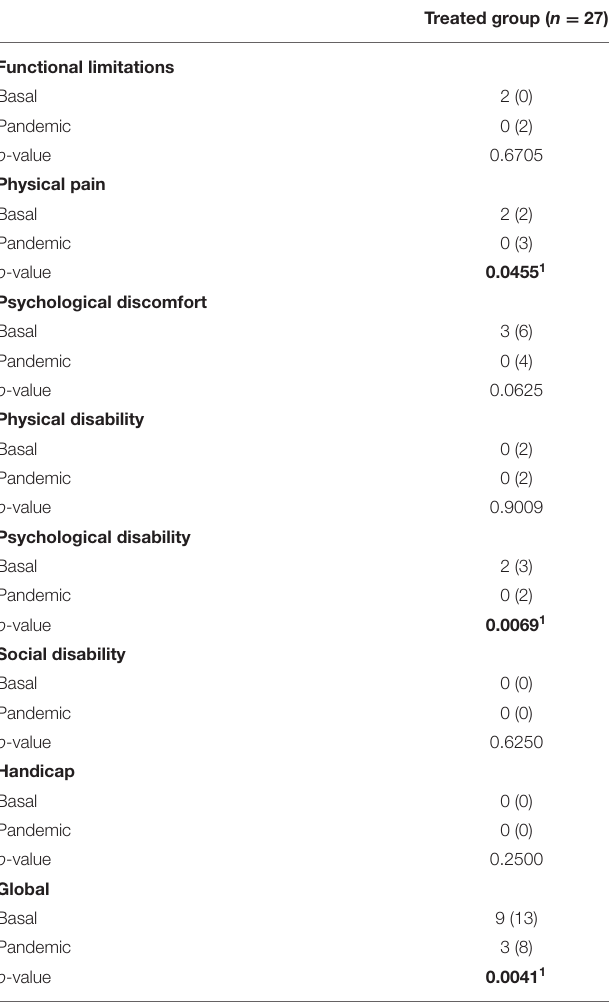
TABLE 2 | Baseline and pandemic OHIP-14Sp score in treated patients [median (interquartile range)].